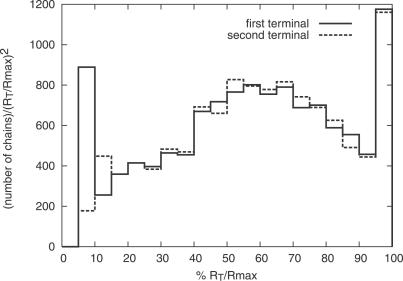
Distribution of the Distance of a Protein Terminal from the Center of Mass (RT)(Rmax is the distance of the residue farthest from the center of mass of the protein chain.) The distribution is divided by (RT/Rmax)2 to obtain a density and to take into account that a point chosen at random within a sphere is more likely to be found away from the center of the sphere.